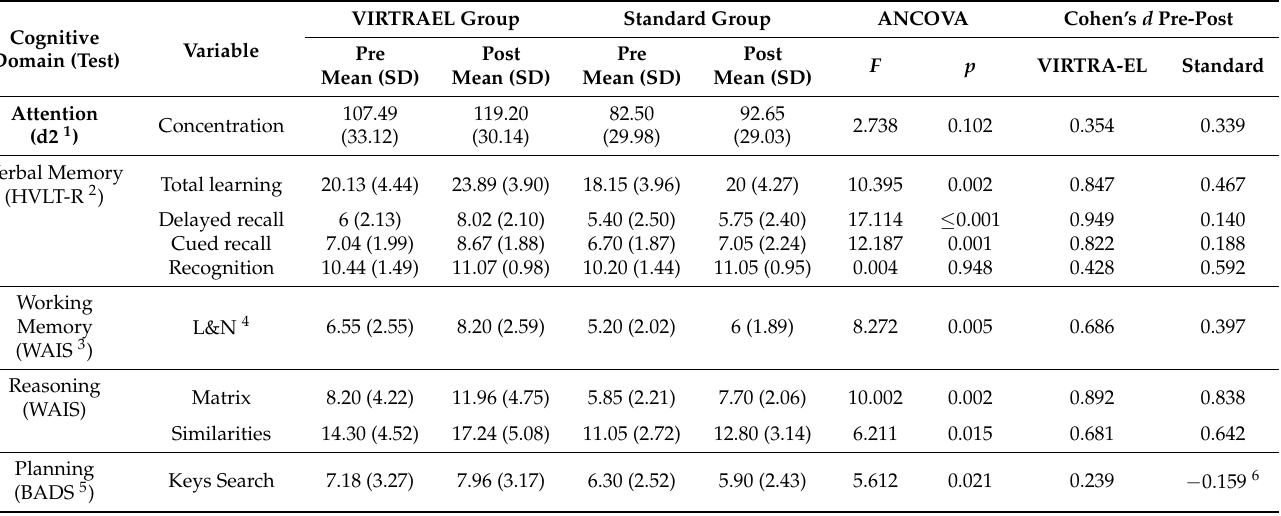
Figure 3. Mean clinical change in the VIRTRAEL and standard groups for the indices of each cognitive function. Table 2. Results of group differences in effectiveness and clinical change between VIRTRAEL and standard